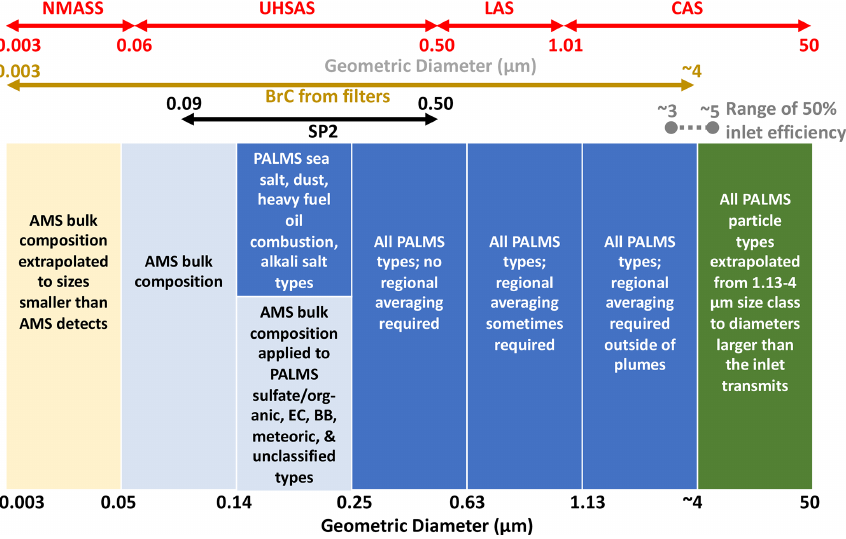
Figure 3. Schematic showing the portions of the size ranges of the particle size distribution instruments that are used and the size ranges over which the composition measurements from the filter measurements, the SP2, the AMS, and PALMS are applied. The approximate range of 50% inlet transmission efficiency is shown. The needs to average PALMS data to achieve statistically significant descriptions of particle composition are shown, as are the extrapolations of AMS and PALMS data to sizes for which no compositional information is available. The diameter ranges of instrument detection are presented in detail in Guo et al.